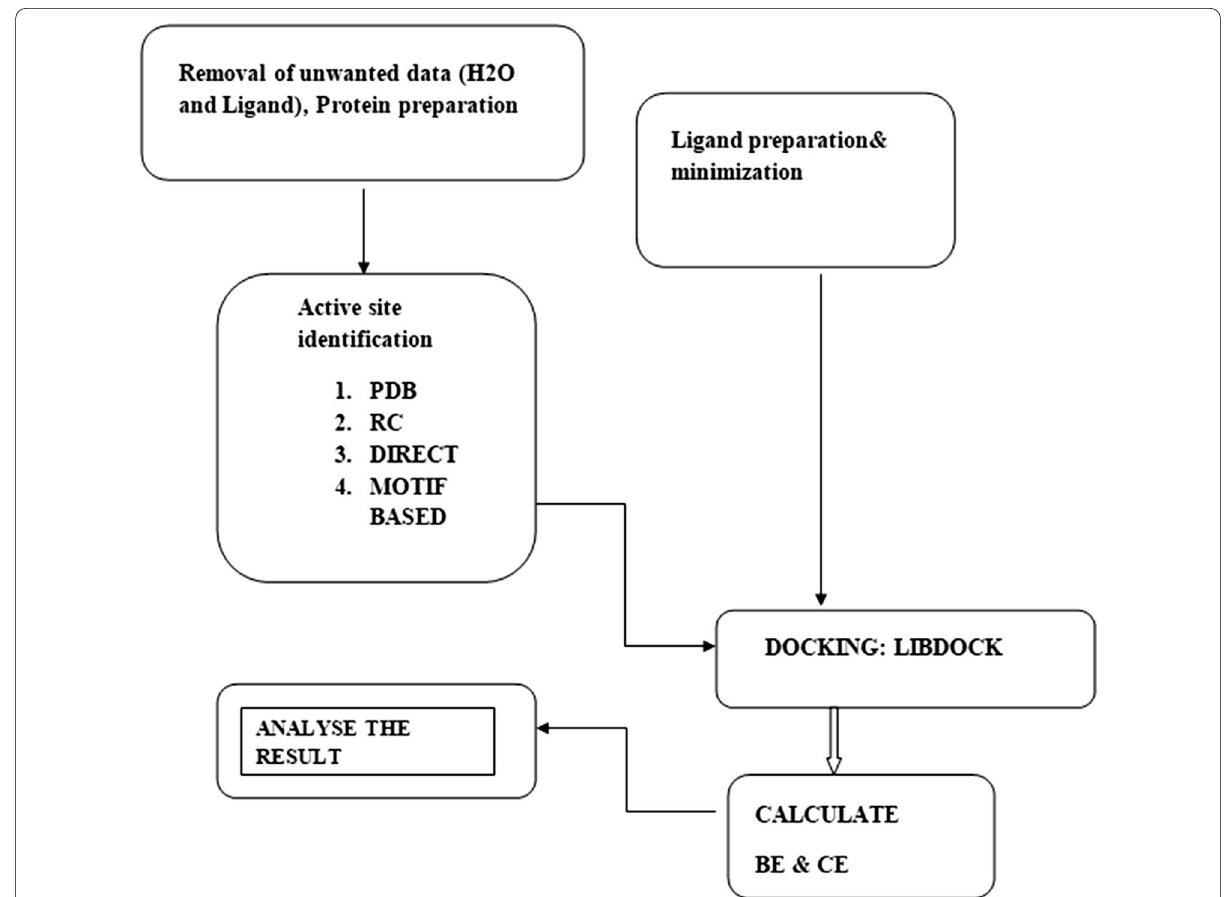
Fig. 1 Pictorial representation of pipeline used in the in silico